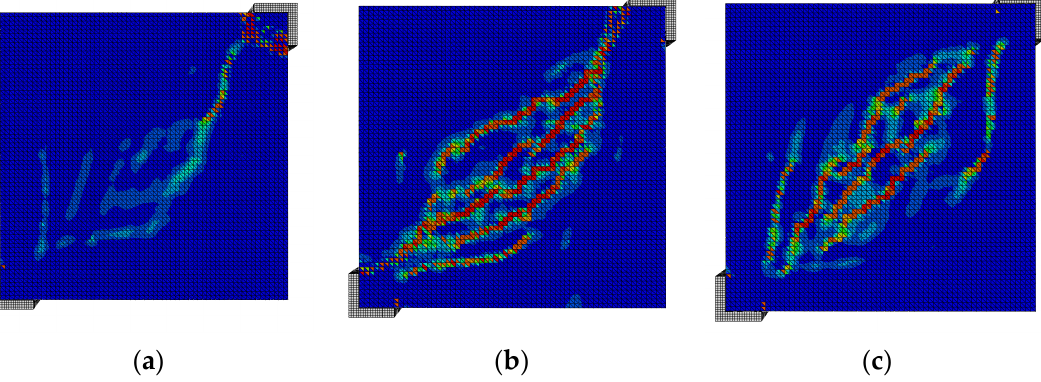
Figure 27. Damage pattern at the peak load of tension for ( a ) fc20, ( b ) fc30, ( c ) fc40.